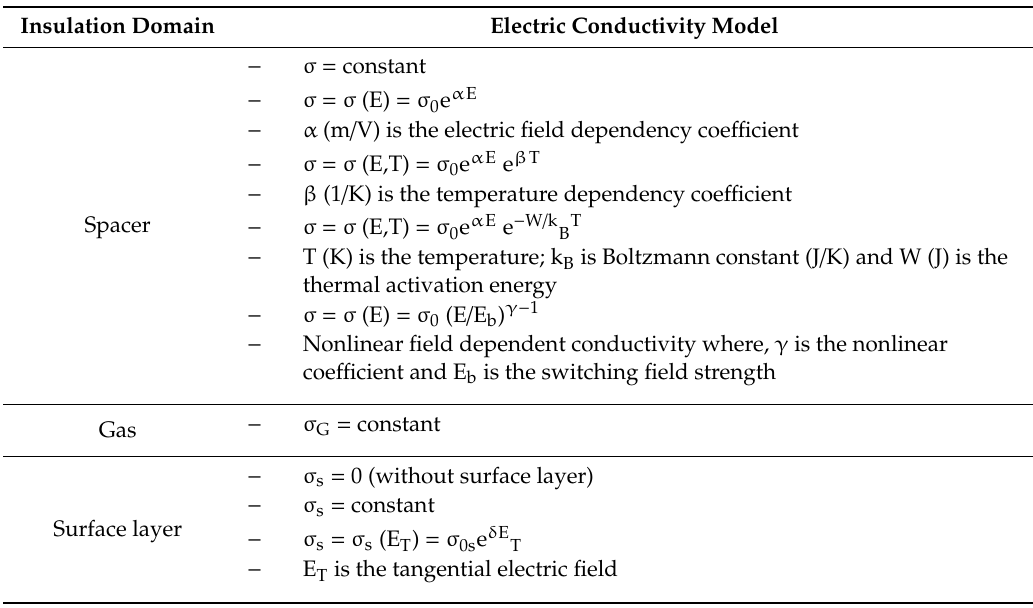
Table 1. Electric conductivity models considered for the electric field